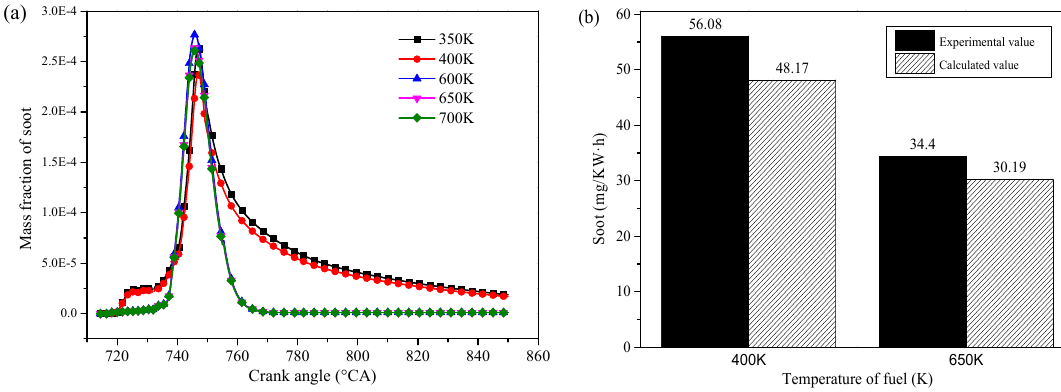
Figure 11. (a) Change curve of the mass fraction of soot; (b) comparison of soot emission. Figure 11. ( a ) Change curve of the mass fraction of soot; ( b ) comparison of soot